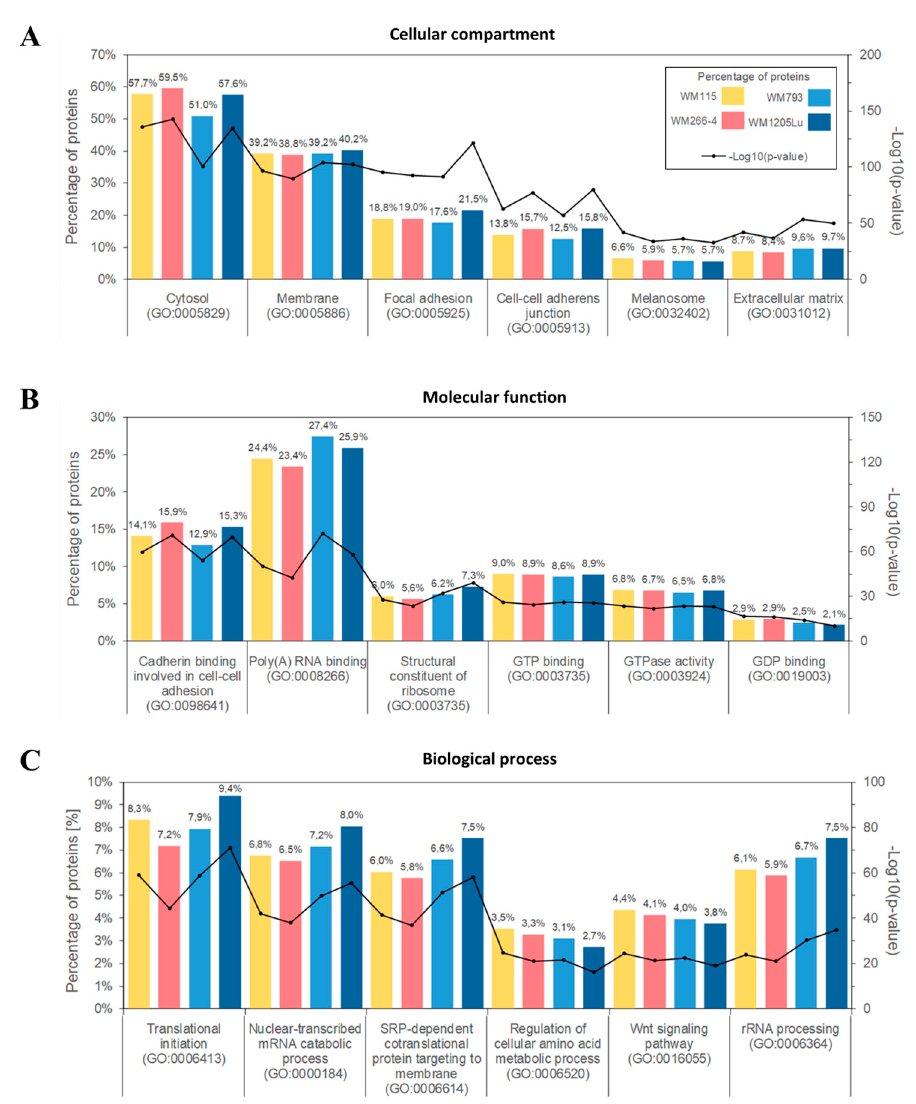
Figure 3. Gene ontology (GO) analysis of CM ectosomal proteins from four different cell lines performed with the use of FunRich 2.0 software with UniProt (release 2019_11) database as a reference. For each GO term (“Cellular compartment” ( A ), “Molecular function” ( B ), “Biological process” ( C )), six categories with the highest statistical significance of protein enrichment within the specific category ( p < 0.001) were presented on graphs. Ectosomes were isolated from WM115 (primary) and WM266-4 (metastatic) cell lines originating from the same individual, radial/vertical